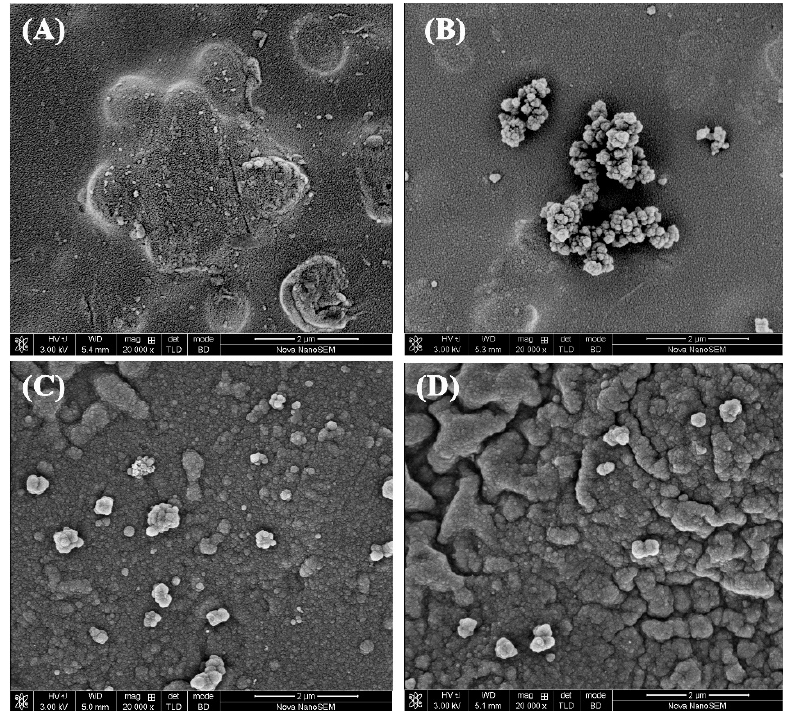
Figure 2. SEM images of species prepared by pyrrole polymerization in ( A ) water, ( B ) [C 2 mim]Br, ( C ) [C 6 mim]Br and ( D ) [C 12 mim]Br aqueous solutions.